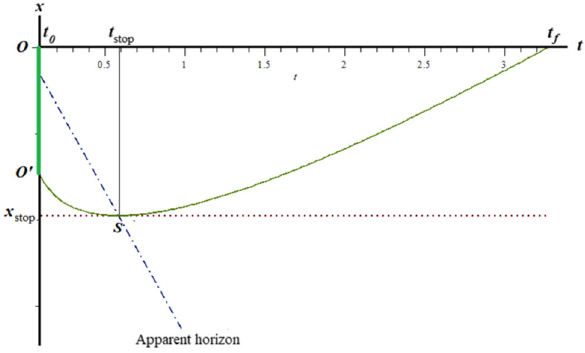
Fig. 3 Propagation of the wave packet with γ = 0 . 1 and ¯ k = 1000 Fig. 2 Profile of the null geodesic x m ( t ) of the maximum intensity in the space-time with s = 0 . 3 and r a ( t 0 ) = 1 . The packet is prepared of the wave packet with γ = 0 . 1 and ¯ k = 1000 in the space-time 3 in O (cid:4) at the time t 0 = 0 . 1 and d = 1 > r a ( t 0 ) and measured in with s = 0 . 3, and r a ( t 0 ) = 1 . The packet is prepared in O (cid:4) at the 3 O at the time t f = 1 . 9504. We plot eight consecutive profiles of the time t 0 = 0 . 1 and d = 1 > r e ( t 0 ) and measured in O at the time maximum intensity I ( t , x ) (in logarithmic scale) between t 0 and t f at t f = 1 . 9504. The maximum intensity stops in x stop = − 1 . 164 at the equal time intervals, Δ t = 0 . 2643. The maximum intensity stops in time t stop = 0 . 3492 x stop = − 1 . 1642 at the time t stop = 0 .